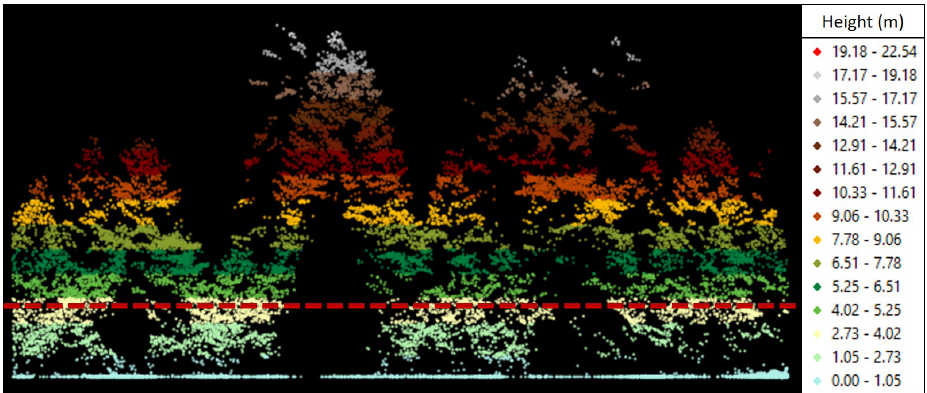
Figure 2. A vertical cross section of plot 29 (Table 1). The horizontal dashed line represents the plot-level CBH measured on the